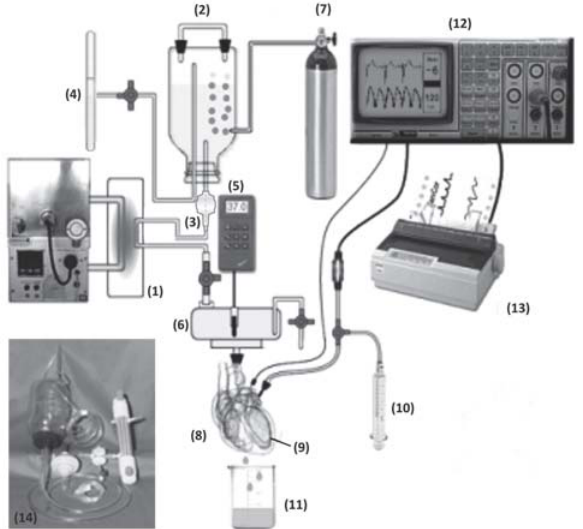
.Fig. 2 - Diagrama do Sistema de Estudo do Coração Isolado . 1. Termopermutador, 2. Reservatório de perfusato. 3. Microfiltro (20µ), 4. Manômetro, 5.Teletermômetro, 6. Câmara, 7. Carbogênio +5% C0 ), 8. Coração, 9. Balão intraventricular, 10. (95% 0 2 2 Injetor de drogas, 11 . Coletor de Fluxo, 12. Monitor de ECG e Pressão Ventricular, 13. Impressora, 14. Conjunto descartável